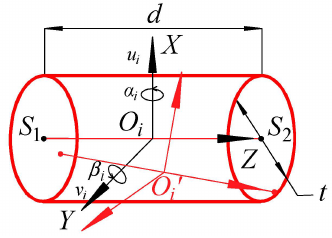
Figure 2. Variation of axis tolerance features (TF) in cylinder tolerance zone.